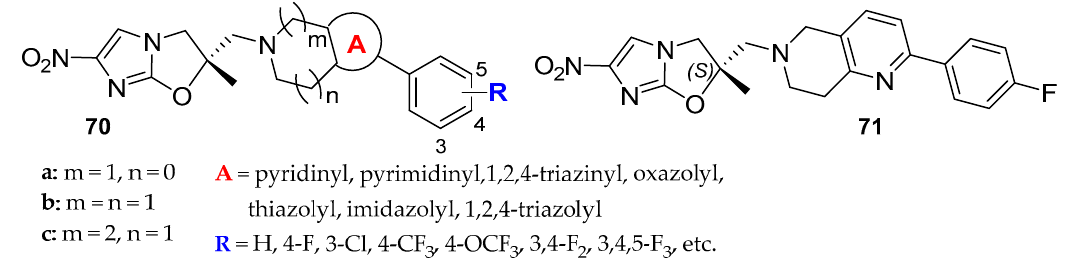
Figure 18. Delamanid analogues 70a – c and 71 with fused bi-heterocyclic linkers.